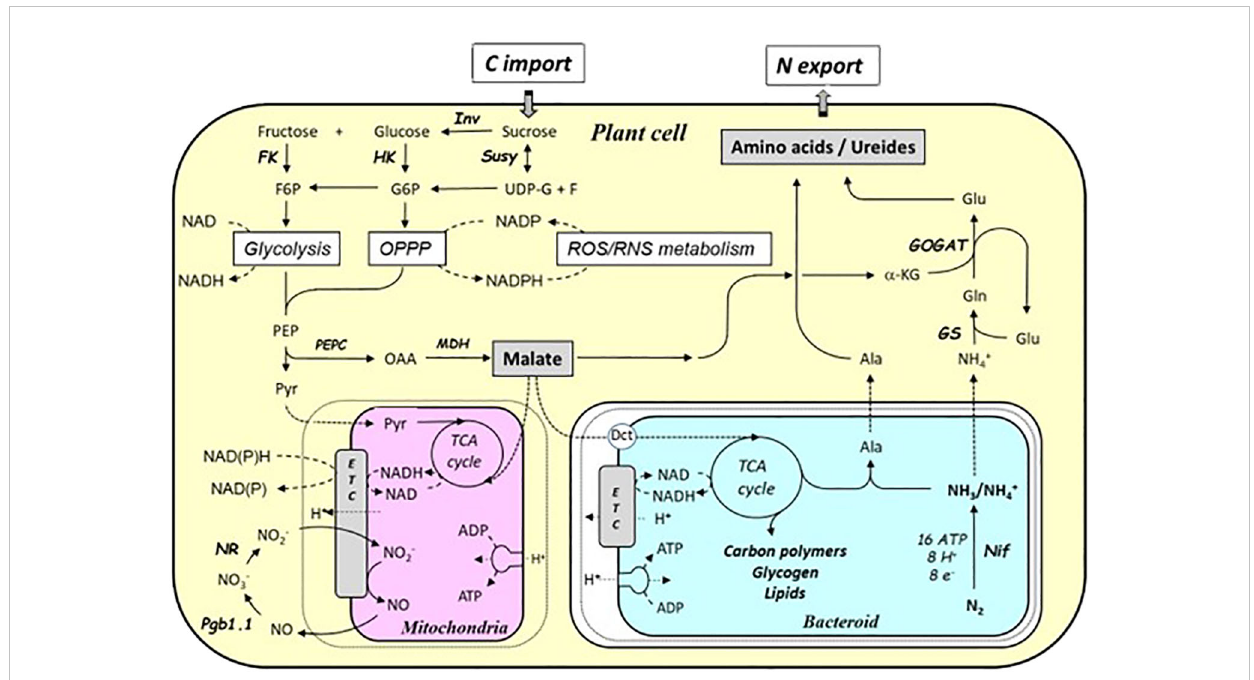
FIGURE 4 Schematic representation of the carbon and nitrogen metabolic pathways in mature nodules. Sucrose is fi rst oxidized through glycolysis and oxidative pentose phosphate pathway to generate reducing power (NADH, NADPH) and phospho enol pyruvate (PEP). PEP, on the one hand, supplies pyruvate to the mitochondria to fuel energy metabolism and, on the other hand, supplies the carbon skeletons to produce organic acids (malate, succinate). Part of the organic acids are supplied to the bacteroids and contribute to generating the reducing power and the energy necessary for the reduction of atmospheric nitrogen (N 2 ) into ammonia (NH 4+ ) by nitrogenase. Another part is used to produce the a -keto acids involved in the assimilation of NH 4+ from bacteroids, via the glutamine synthetase/glutamate synthase pathway. Assimilated N is exported, as either amino acids (indetermined nodules) or ureides (determinate nodules), to the whole plant. Ala, alanine; Dct, dicarboxylate transporter; e - , electron; ETC, electron transfer chain; F6P, fructose-6-phosphate; FK, fructokinase; G6P, glucose-6-phosphate; GOGAT, glutamate synthase; Gln, glutamine; Glu, glutamate; GS, glutamine synthetase; H + , proton; HK, hexokinase; Inv, invertase; a -KG, a -ketoglutarate; MDH, malate dehydrogenase; N 2 , dinitrogen; NH 4+ , ammonium; Nif, nitrogenase; NO, nitric oxide; NO 2 − , nitrite; NO 3 − , nitrate; NR, nitrate reductase; OPPP, oxidative pentose phosphate pathway; PEP, phospho enol pyruvate, PEPC, PEPC carboxylase; Pgb1.1, phytoglobin 1.1; Pyr, pyruvate; ROS/RNS, reactive oxygen species/ reactive nitrogen species; Susy, sucrose synthase; TCA, tricarboxylic acid cycle; UDP-G, UDP